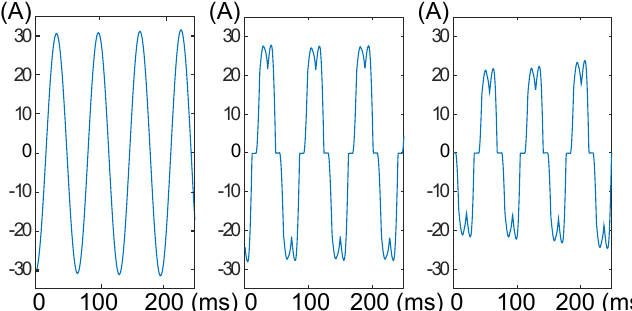
Figure 10. Currents in one phase from the generator. From left to right: AC load, fixed PWM and constant DC.